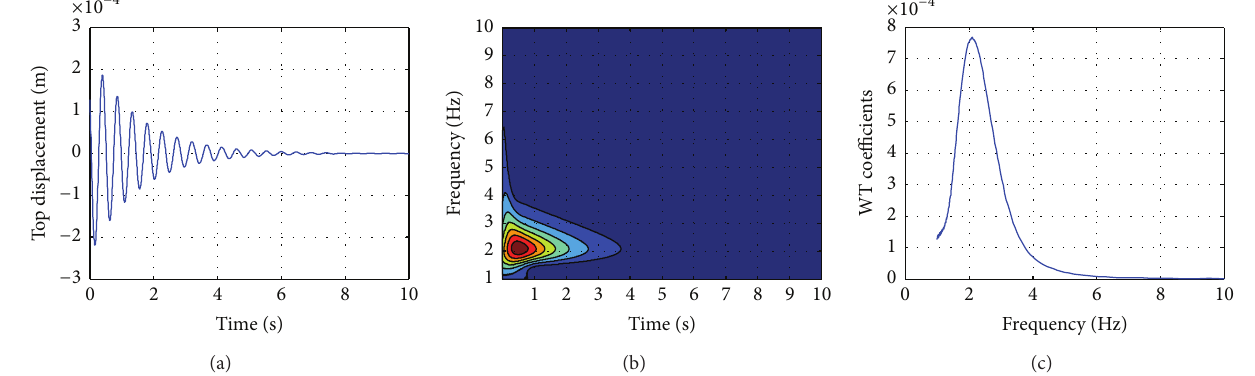
Figure 3: (a) Free decay response at top story, (b) its time-frequency resolution, and (c) the extracted window parallel to frequency axis at the wavelet ridge.